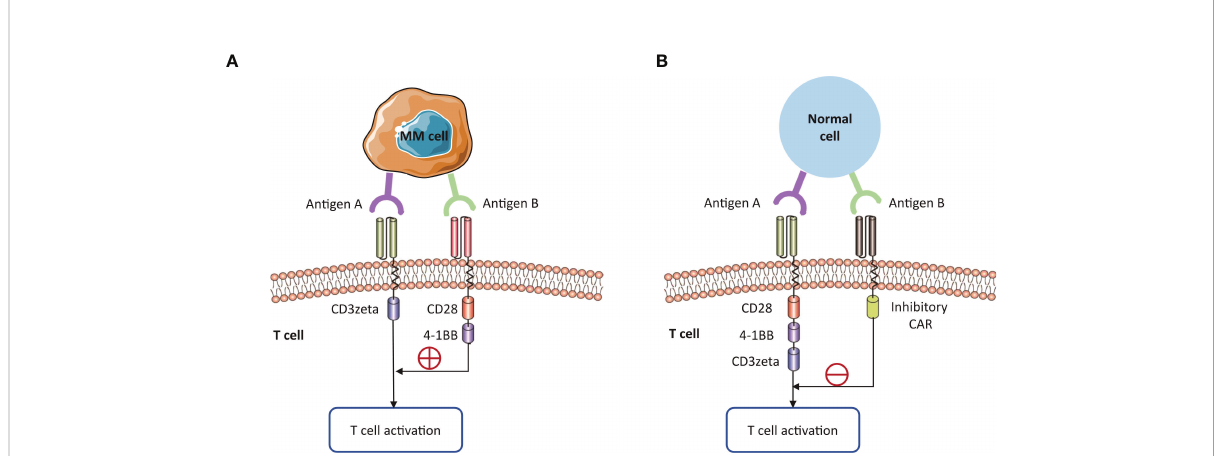
FIGURE 6 Strategies to overcome on-target, off-tumor toxicity. The expression of tumor-associated antigens on healthy tissues can lead to ‘ on-target, off- tumor ’ toxicity. (A) The speci fi city of CAR T cells is enhanced by targeting multiple TAAs. The activation domain and co-stimulatory domain should respectively bind to different antigens on MM cells for CAR T cell activation. (B) Alternative strategy is to use the inhibitory CAR against a speci fi c non-tumor antigen, requiring the absence of this antigen on MM